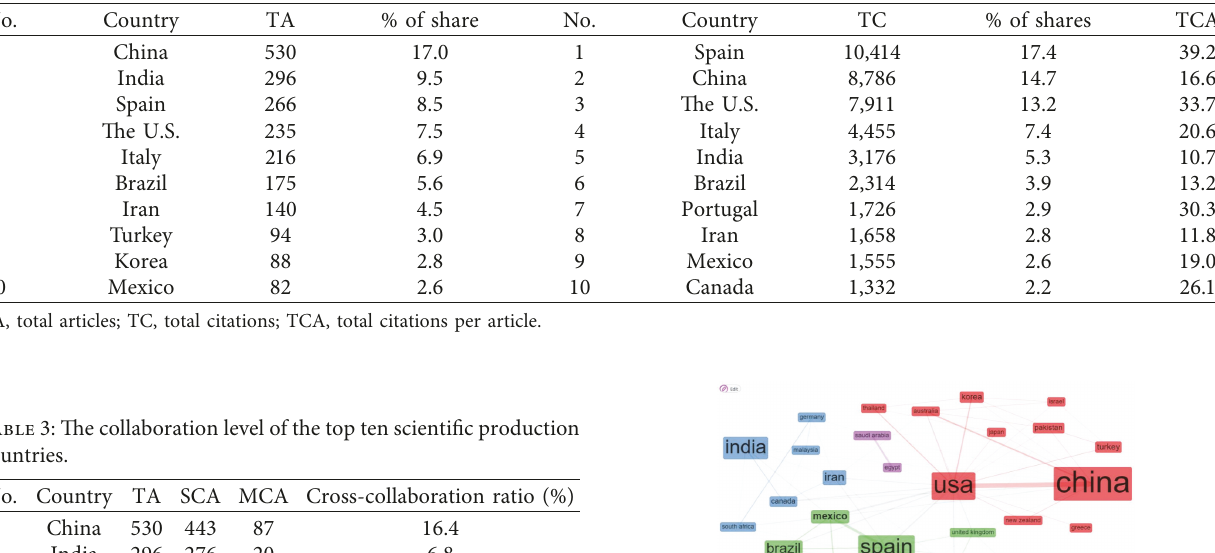
Table 2: Top 10 scientific production countries based on articles and citations.